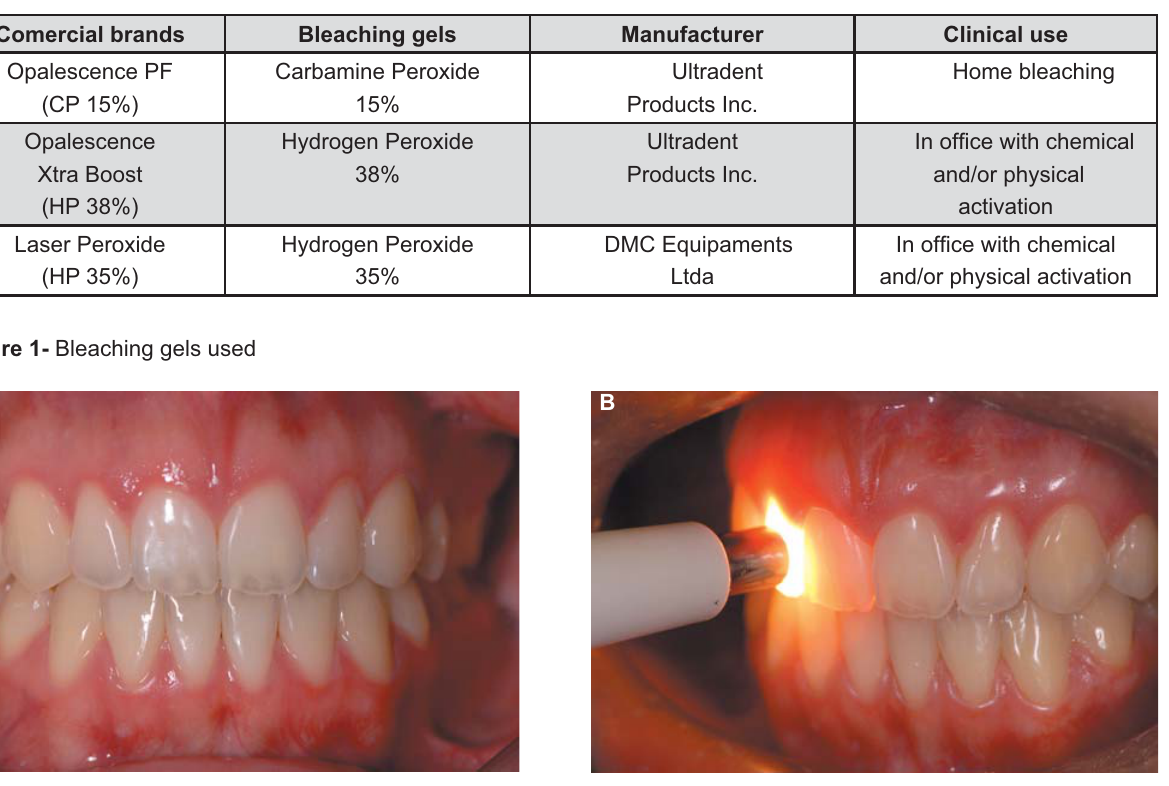
Figure 2- (A) Initial photo and (B) spectrophotometer color measurement